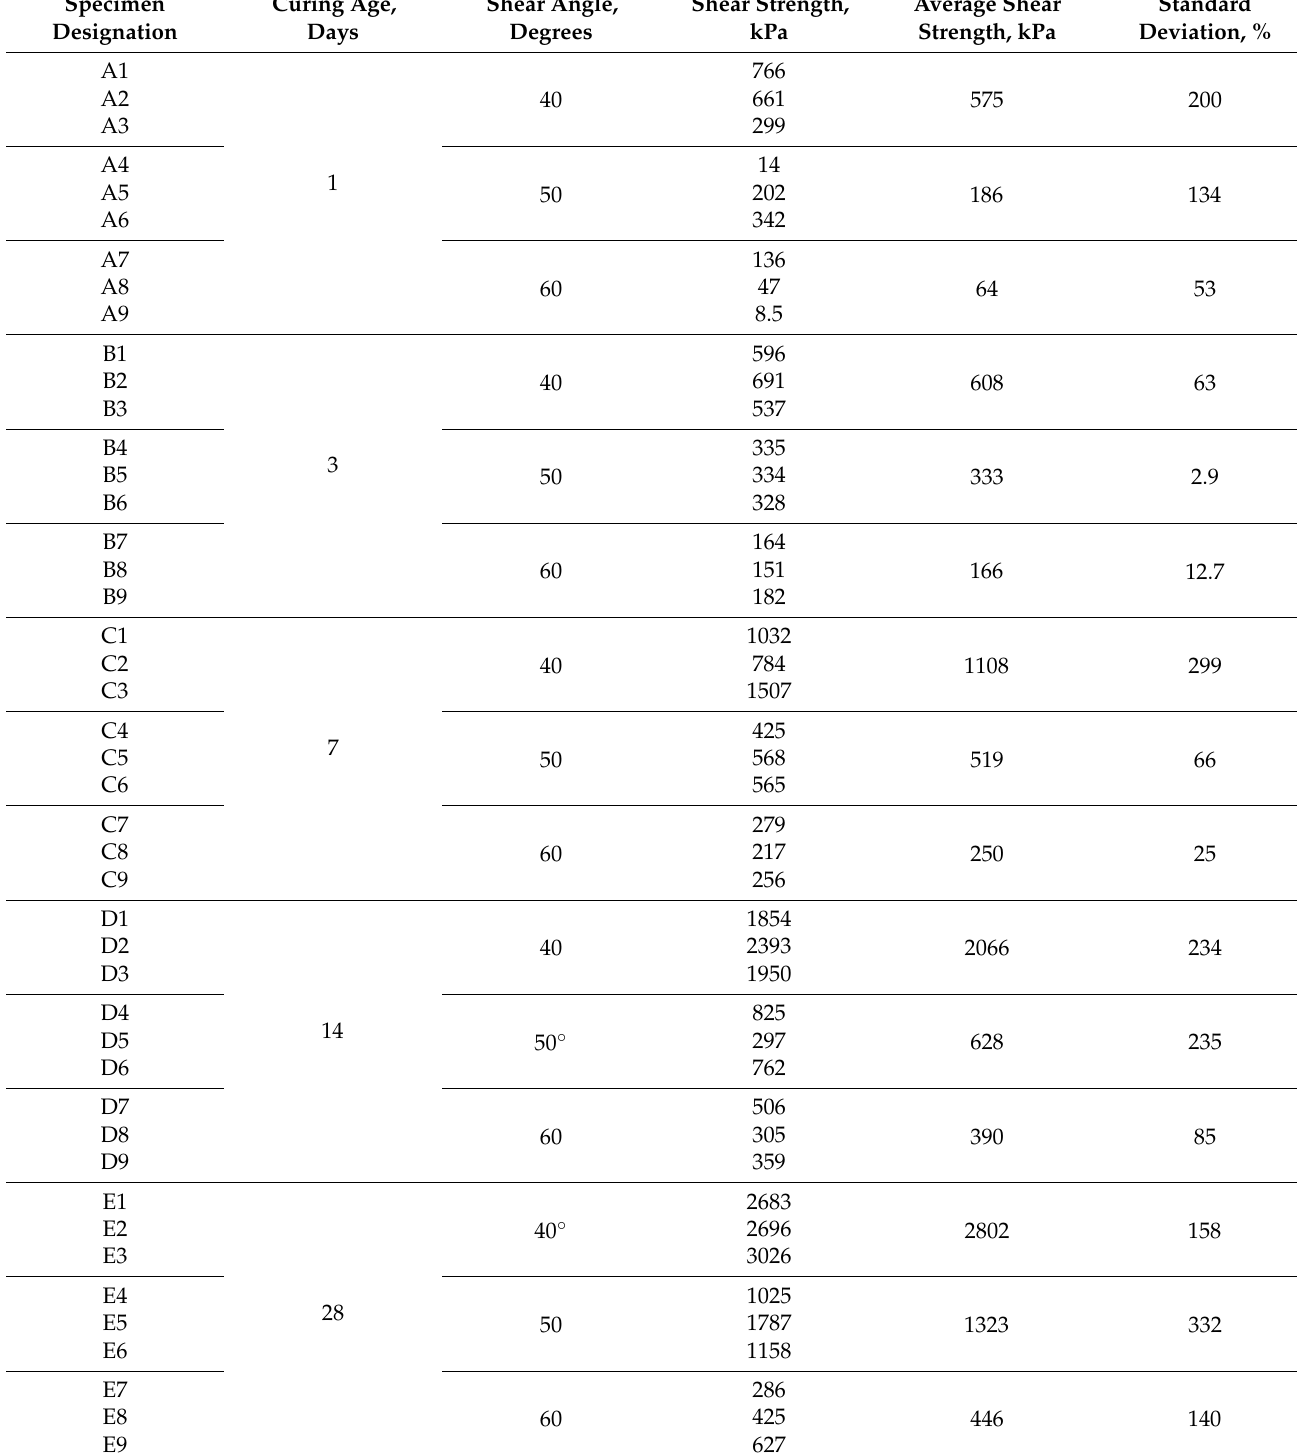
Table 5. Experimental shear strength values of tested